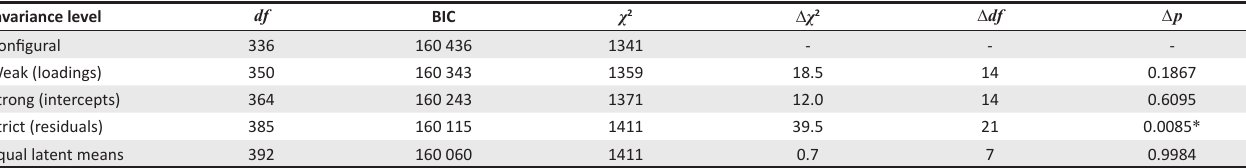
TABLE 1: Chi-square test and change in chi-square statistics. Invariance level